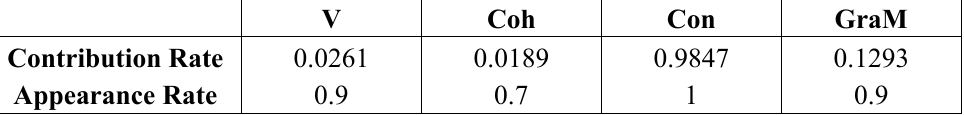
Table 3. The contribution rate and appearance rate of second level candidate features.